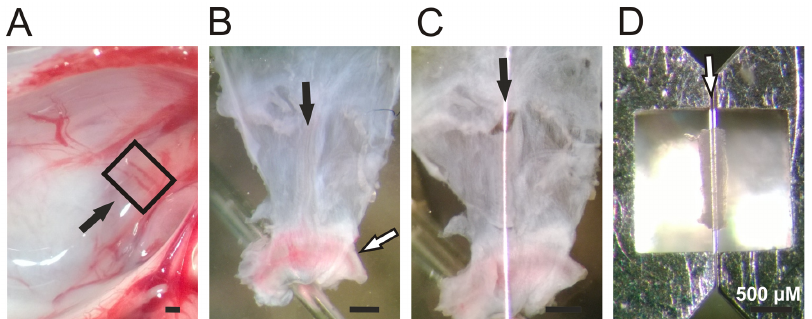
Figure 1. Isolation of the middle meningeal artery (MMA). A) The MMA on the inside of the rat scull, the arrow illustrates which fragment was utilised. B) The dura is dissected, stretched and held by needles, the MMA is shown with the black arrow and the internal maxillary artery (IMA) with the white arrow. C) A 25 m m steel wire (arrow) is guided through the MMA after it has been cut into a , 2 mm segment. D) The MMA (here , 1.350 mm long) is mounted with a second wire, in a wire myograph (arrow). Scale bars are 500 m